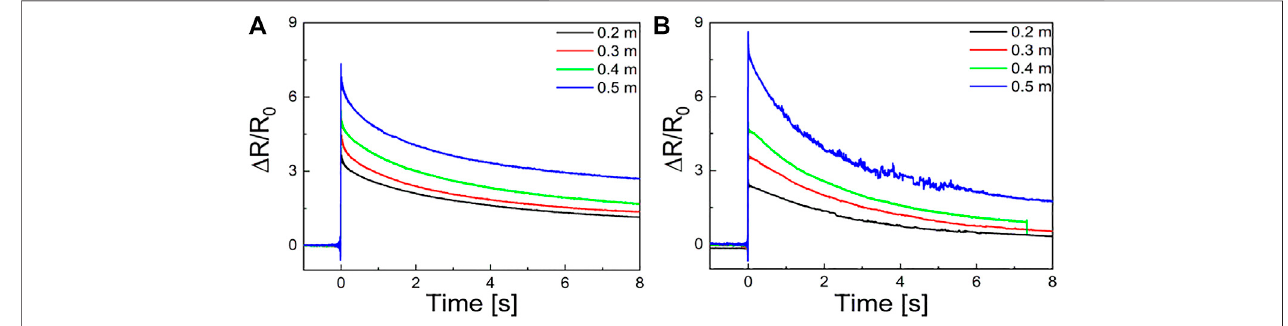
FIGURE 9 | The recovery behaviors of the electrical properties under drop weight impact with the strength of the external magnetic fi eld are zero (A) and the strength of the external magnetic fi eld is 0.3 T (B) .